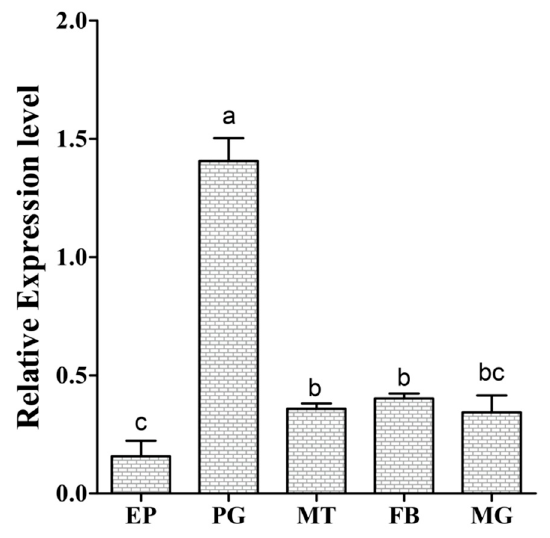
Figure 4. The relative Cs-Phm transcript level measured in various larval tissues using qRT-PCR. The larval tissues (EP—epidermis; PG—prothoracic glands; MT—Malpighian tubules; FB—body fat; and MG—midgut) were dissected from 4th day of 5th-instar larvae. The columns indicate average values, and vertical bars represent SE. Different letters indicate significant differences at p value < 0.05.